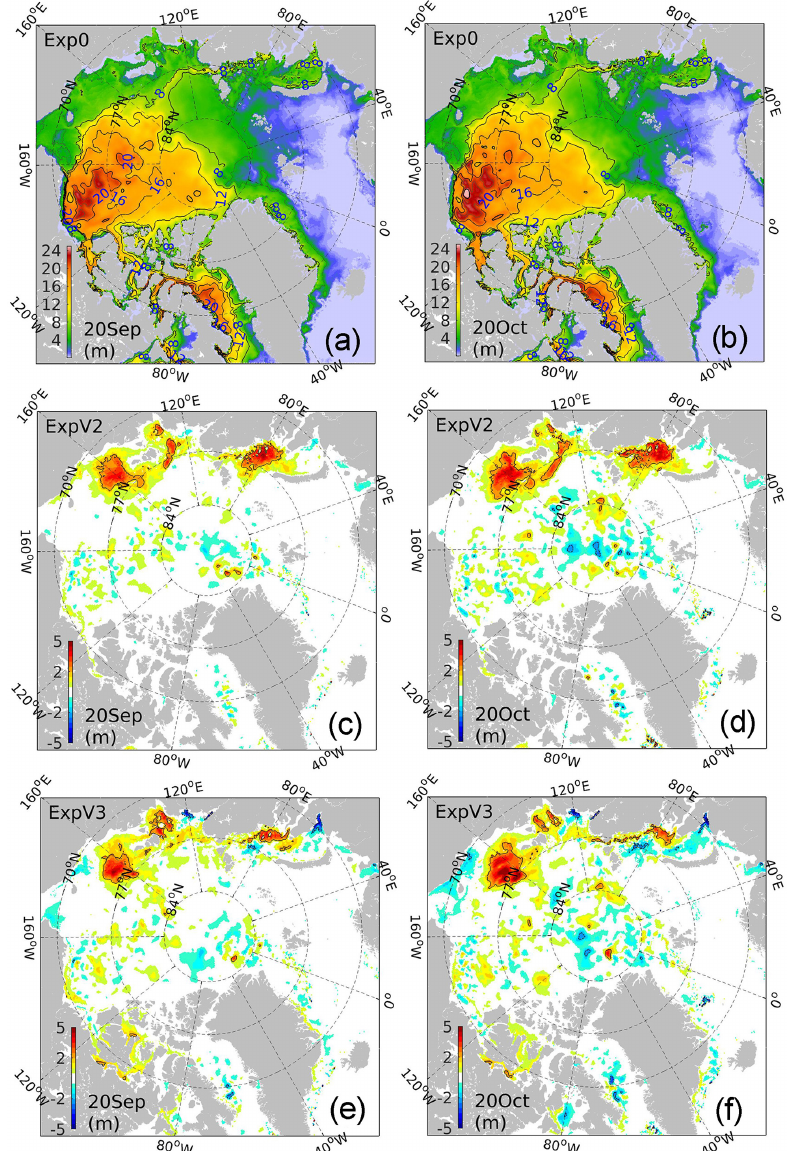
Figure 10. (a, b) Freshwater contents (unit: m) on 20 September and 20 October 2016 in the Arctic Ocean from the three assimilation runs: Exp0. The interval of isolines is 4m. (c–f) The FWC differences in ExpV2 (c, d) and ExpV3 (e, f) concerning those in Exp0. The black lines indicate − 2 and 2m